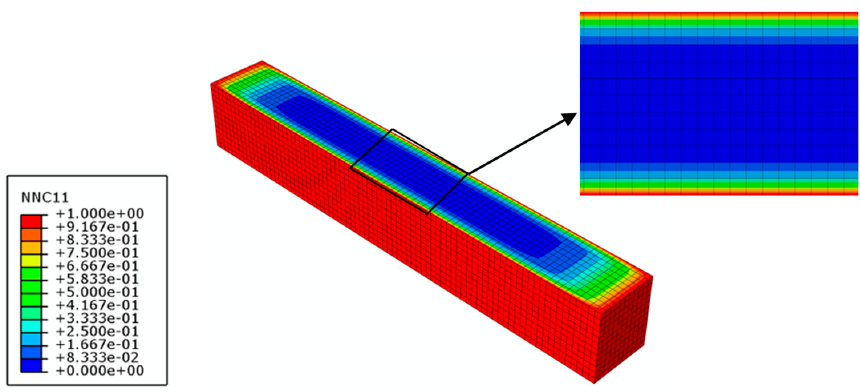
Figure 12. Moisture concentration distribution across the mid-plane of the GFRP specimen with 50% moisture uptake content (time = 107 h).